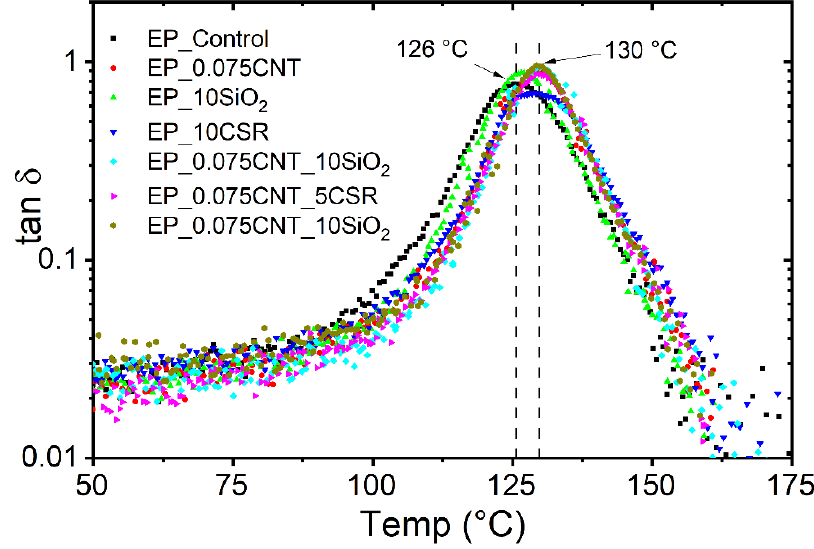
Figure 1. Dynamic mechanical analysis (DMA) (tan δ peak) curve to obtain glass transition temperature of reference and different modified epoxy system. Table 3. Tensile and fracture mechanics properties of reference and modified epoxy